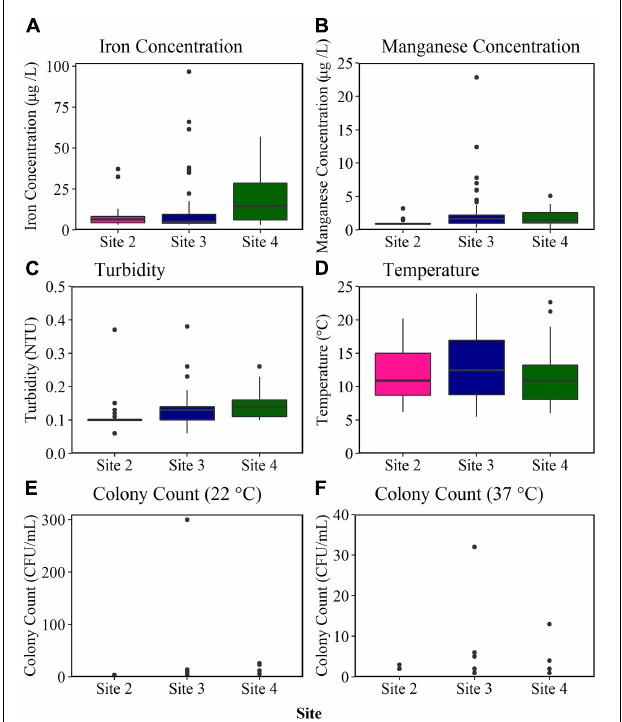
FIGURE 6 | Historical bulk water quality data obtained from random daytime sampling of district metered areas (DMAS) supplied by Site 2, Site 3, and Site 4 trunk mains for the last 6 years. Median, interquartile range and range are plotted. Outlier values are marked with a black circle. NTU, nephelometric turbidity unit; CFU, colony-forming unit; Iron n = 27 Site 2; n = 66 Site 3; n = 32 Site 4. Manganese n = 26 Site 2; n = 66 Site 3; n = 32 Site 4. Turbidity n = 25 Site 2; n = 63 Site 3; n = 27 Site 4. Temperature n = 61 Site 2; n = 144 Site 3; n = 49 Site 4. Colony count (22 ◦ C) n = 27 Site 2; n = 68 Site 3; n = 29 Site 4. Colony count (37 ◦ C) n = 27 Site 2; n = 43 Site 3; n = 28 Site 4.